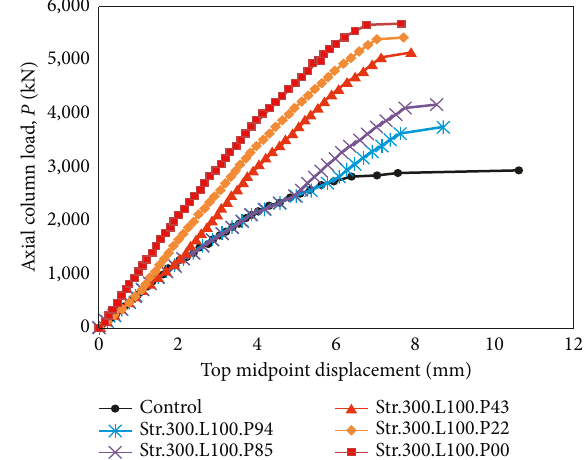
Figure 7: The curves relating to load displacement obtained from FE simulation for columns strengthened by 4L · 50 × 50 × 10 with different percentages of preloading.